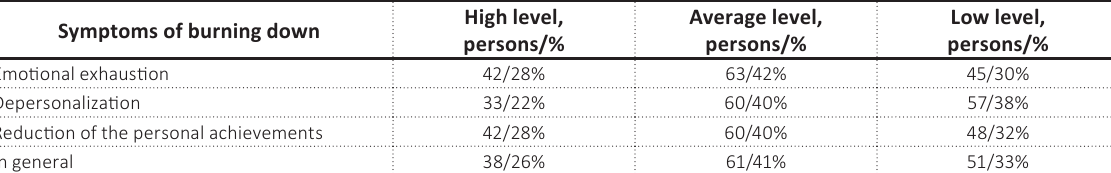
Table 5. Levels of professional emotional burnout of IT employees in Ukraine according to the questionnaire “Professional